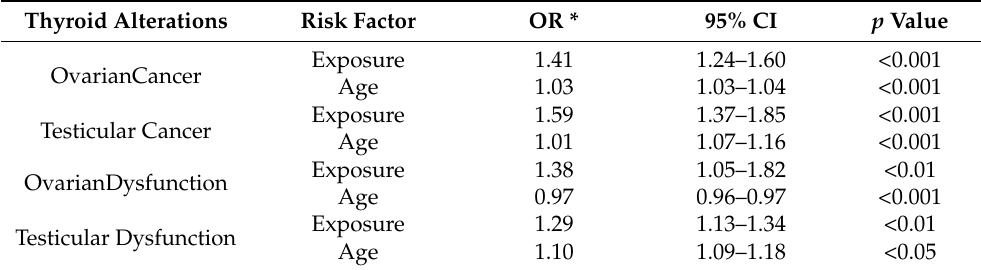
Table 3. Stepwise multiple logistic regression analysis of gonadal alterations adjusted for exposure to pesticides and